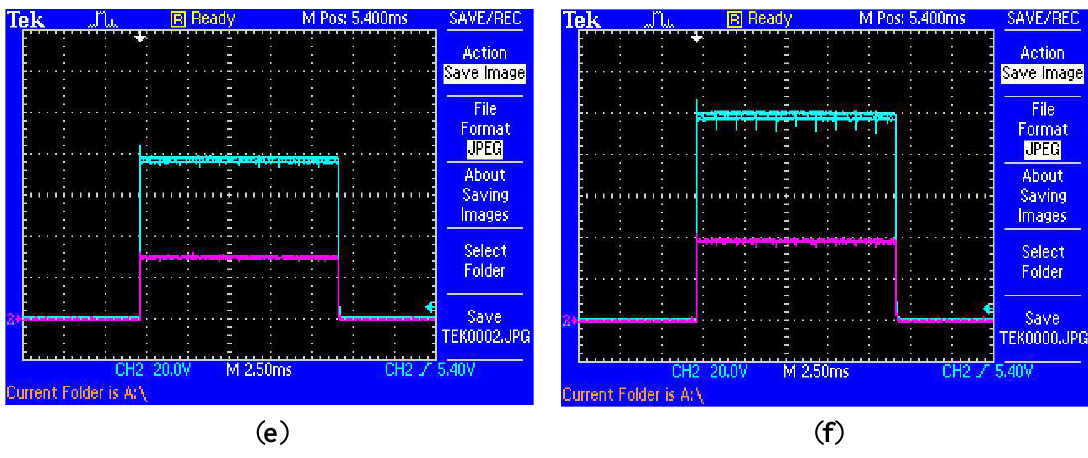
Figure 8. Implant side rectified and regulated output voltage and current for inter-coil separation of 25 mm with R LOAD = 50 Ω at f~185 kHz: ( a ) in sense mode 15.9 V (5 V/div) at 0.32 A (5.1 W); with <8% ripple, Tx-Sense Mode = 15 V, Y-Axis: Output voltage (yellow) = 15.9 V / 0.32 A, (5 V/div); X-Axis: Timebase = 250 ms (25 ms/div); ( b ) Tx-Shock Mode Voltage Setting = 20 V, Y-Axis Ch-1 (green): Output voltage = 19.6 V (10 V/div), Y-Axis Ch-2 (red): Output current = 0.36 A (0.5 A/div); ( c ) Tx-Shock Mode Voltage Setting = 40 V, Y-Axis Ch-1 (green): Output voltage = 39.6 V (10 V/div), Y-Axis Ch-2 (red): Output current = 0.74 A (0.5 A/div); ( d ) Tx-Shock Mode Voltage Setting = 60 V, Y-Axis Ch-1 (green): Output voltage = 59.6 V (20 V/div), Y-Axis Ch-2 (red): Output current = 1.12 A (0.5 A/div); ( e ) Tx-Shock Mode Voltage Setting = 80 V, Y-Axis Ch-1 (green): Output voltage = 76.8 V (20 V/div), Y-Axis Ch-2 (red): Output current = 1.48 A (1 A/div); ( f ) Tx-Shock Mode Voltage Setting = 100 V, Y-Axis Ch-1 (green): Output voltage = 98.4 V (20 V/div), Y-Axis Ch-2 (red): Output current = 1.9 A (1 A/div); with an average waveform tilt of <3.5% measured.